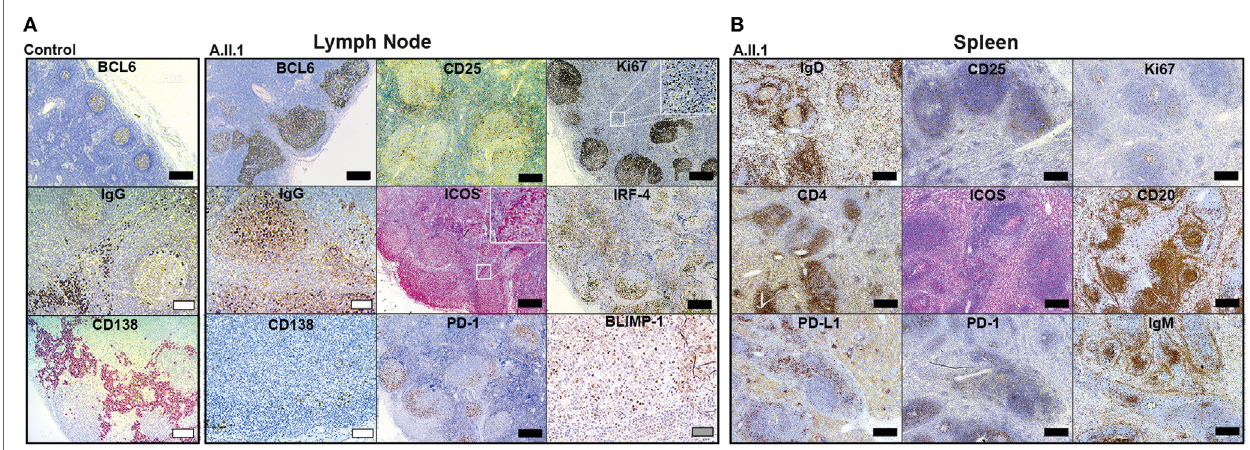
FigUre 4 | Immunohistochemistry of patient lymph node (LN) and spleen samples. Representative images of immunoperoxidase stainings of LN (a) and spleen (b) tissues. Large germinal centers were identified by staining for BCL6 in the patient’s LN and compared to LN of a healthy control (control). Additional GC markers, such as IgG defining immunoglobulin class-switched plasmablasts, Ki67 for labeling centroblasts, ICOS and PD-1 for follicular T-helper cells (T FH cells), IRF-4 marking plasma blasts, and BLIMP-1 for GC B cells poised to develop into plasma cell are shown in (a) . Additional staining of IgD (resting follicular B cells), IgM (follicular and marginal zone B cells), CD20 (B cells), CD4 (T-helper cells), Ki67 (proliferating cells), ICOS and PD-1 (T FH cells), PD-L1 (B cells and DCs), and CD25 (activated T cells and T REG cells) in the spleen are shown in (b) . Mature plasma cells were identified by staining for CD138 in (a) . Scale bars; black, 500 µm; white, 100 µm; gray, 50